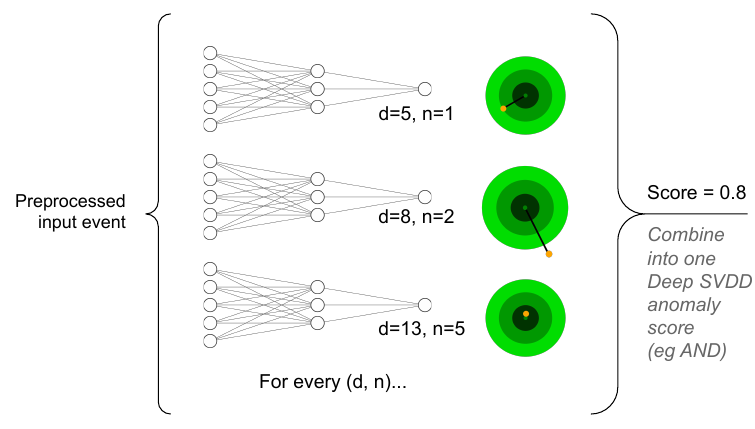
Figure 1: Visualisation of an ensemble of Deep SVDD models. The L2 distance be- tween the network output and the expected fixed number(s) is used as the anomaly score, which is then combined using a combination algorithm described in section 4.